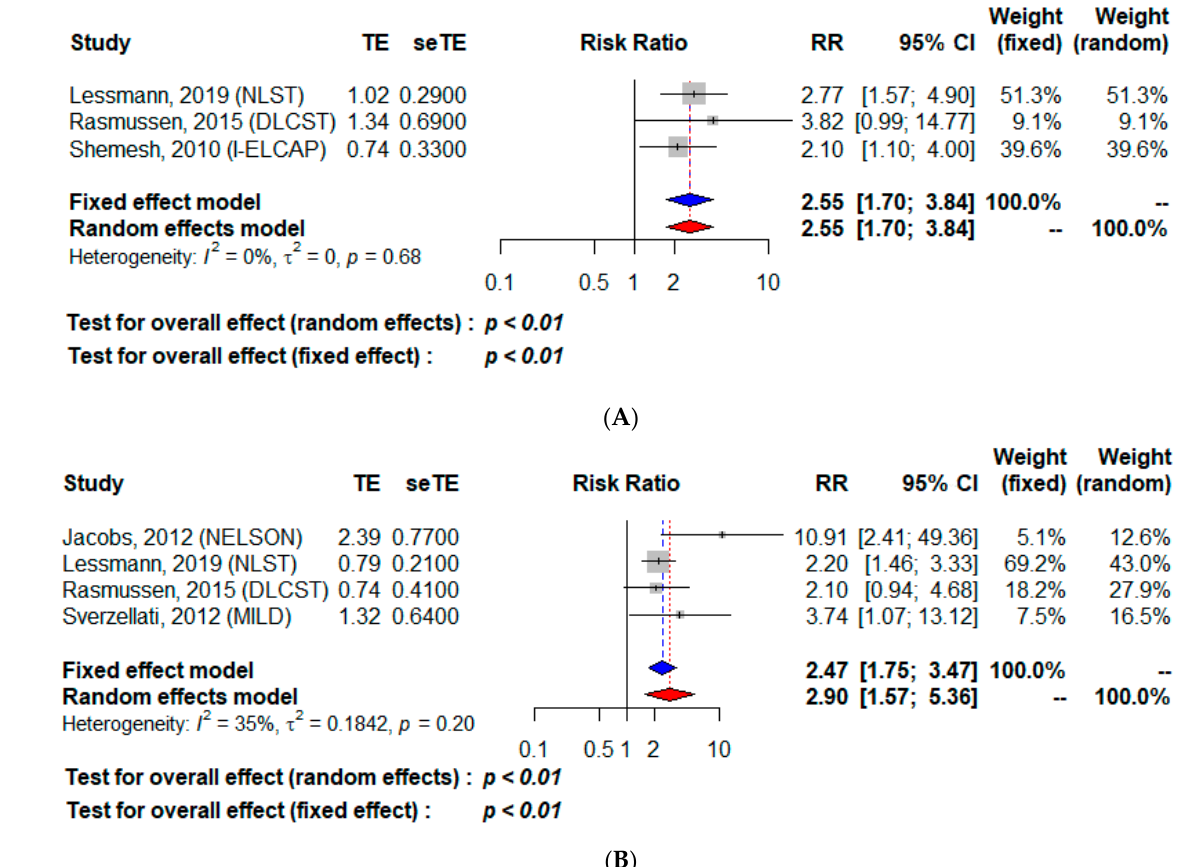
Figure 3. Cardiovascular ( A ) and all-cause ( B ) mortality according to a high coronary artery calcifications score. TE, estimate of treatment effect, e.g., log hazard ratio or risk difference; seTE, Standard error of treatment estimate; RR, relative risk.